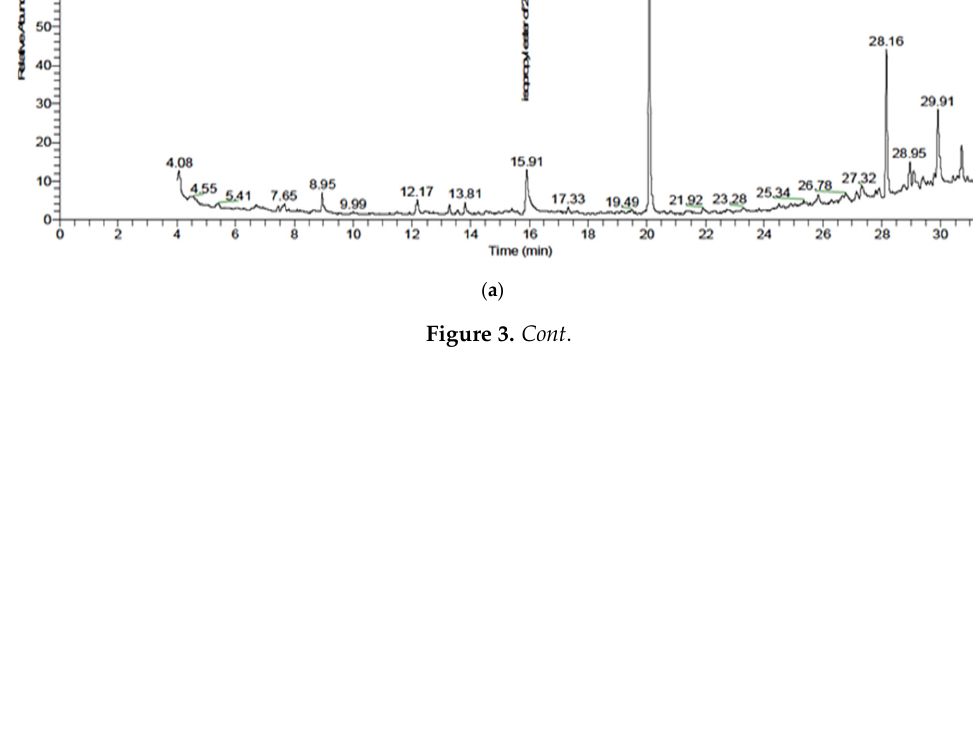
Figure 3. ( a ) Total GC-MS chromatogram of PHB extracted from Bacillus paramycoides. ( b ): The mass spectrum of isopropyl ester of 2-butenoic acid of PHB extracted from Bacillus paramycoides.